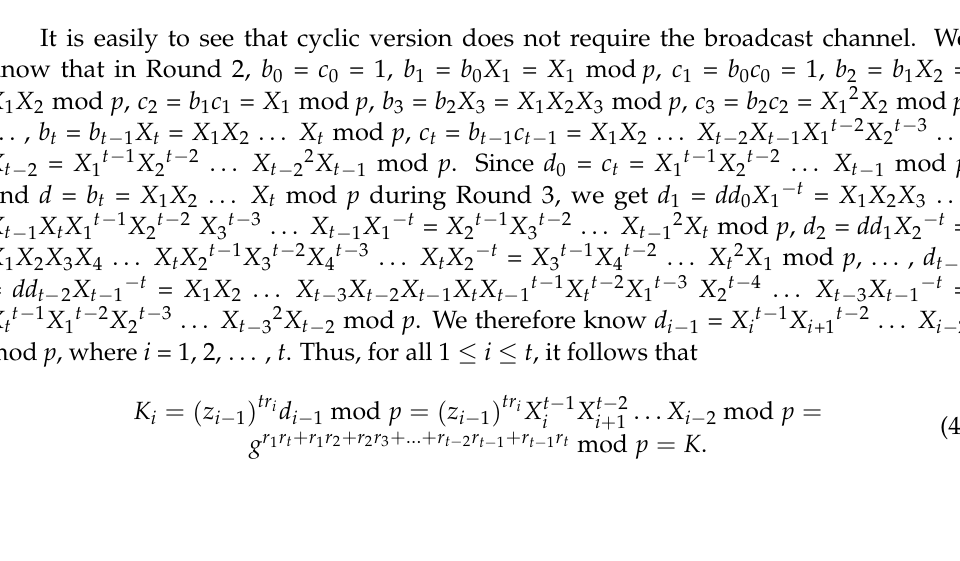
Figure 1. Communication and computation of broadcast protocol.